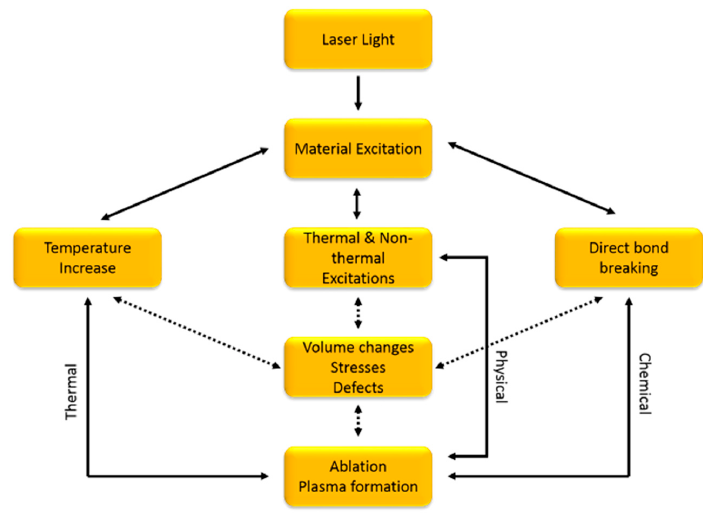
Figure 2. Mechanisms of ablation in laser micromachining. Substrate removal can be a result of thermal ablation, physical ablation, chemical ablation, or a combination of these mechanisms.